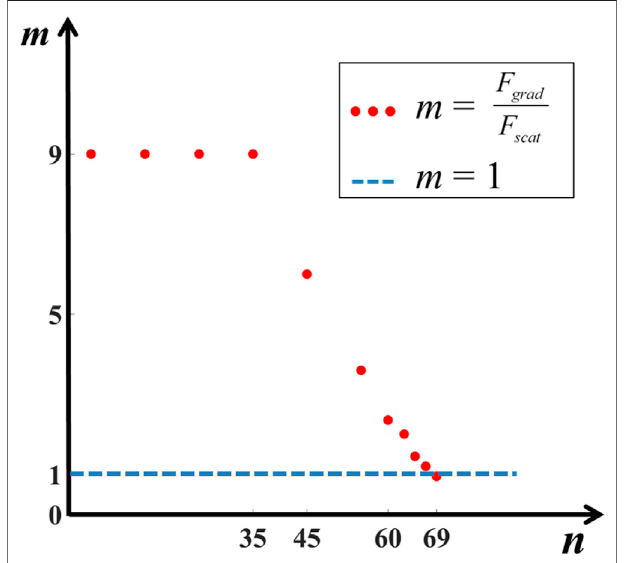
FIGURE 6 | Intensity distribution of the Gaussian lattice with different numbers of arrays. (A) 35×35 array; (B) 45×45 array; (C) 55×55 array; (D) 60×60 array.